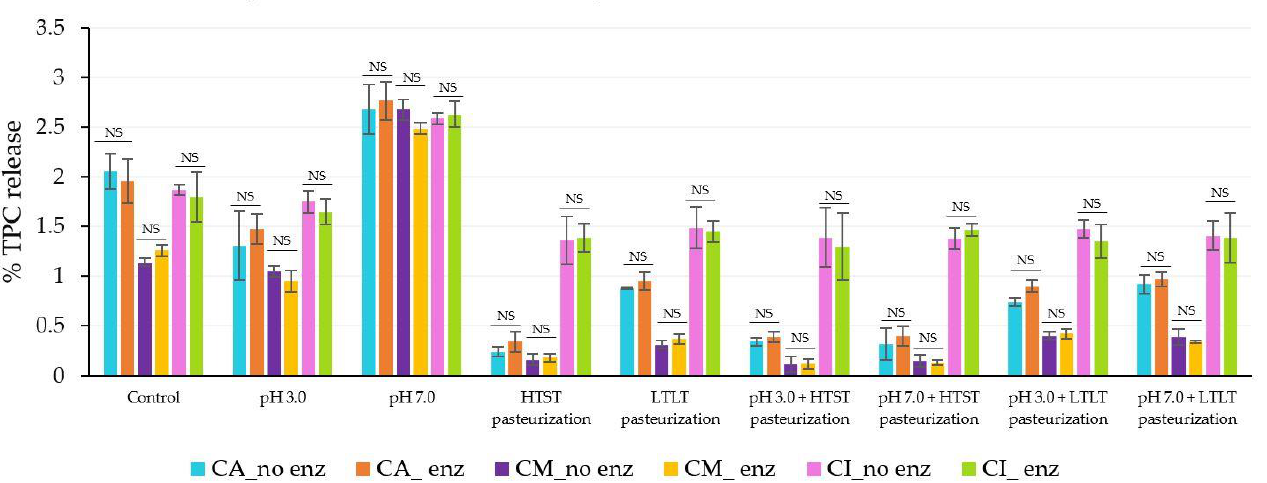
Figure 8. % TPC released during simulated gastrointestinal condition in the gastric phase (120 min) with and without pepsin. NS indicated no significant differences at p ≤ 0.05. The error bars indicate the SD of the data. The control sample was microbeads after air-drying.